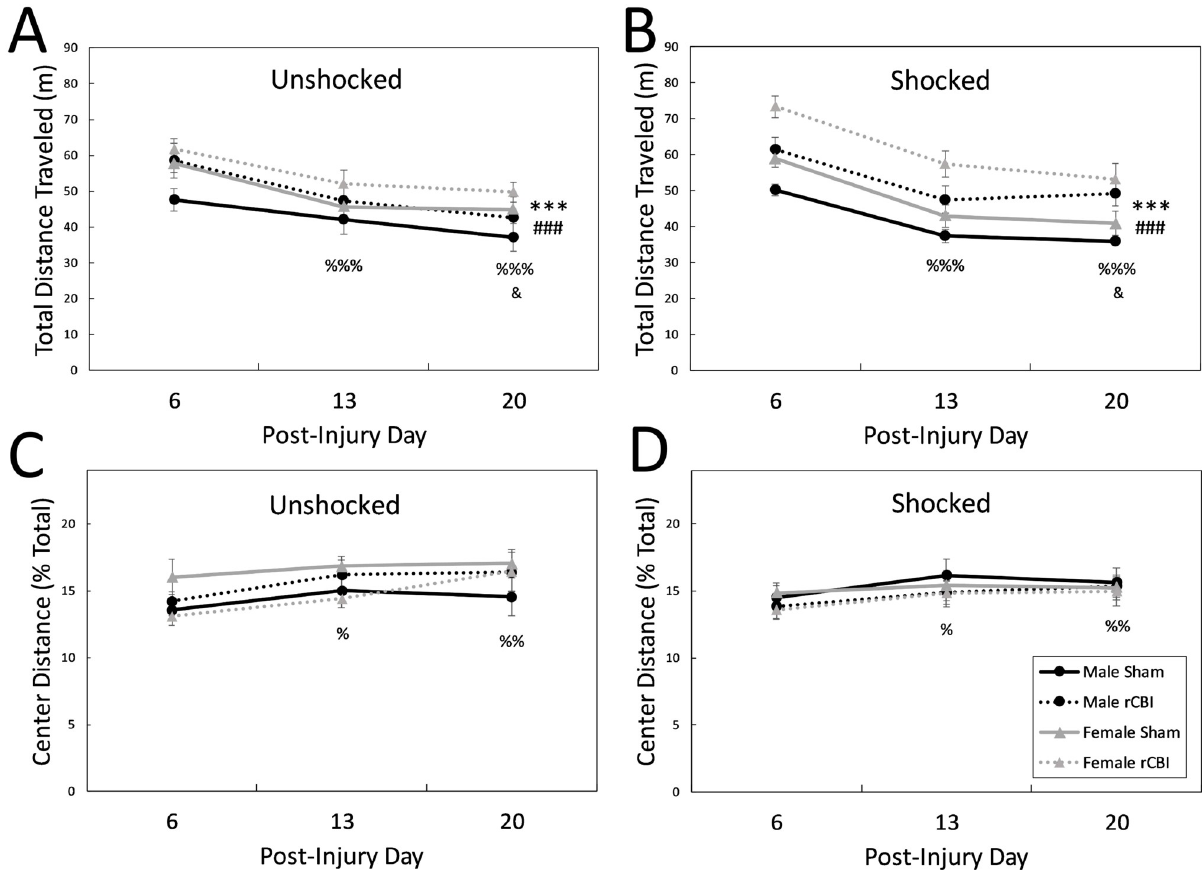
Fig 6. Total distance traveled (A & B) and activity in the center zone (C & D) in the OF arena for unshocked and shocked mice. There were main effects of injury ( ### , rCBI > Sham, p < 0.0001) and sex ( ��� , Female > Male, p < 0.0001) on the total distance traveled in the OF ( A & B ). There was also an effect of day; all mice were less active on days 13 and 20 when compared to the first exposure to the test on day 6 (%%%, Day 6 > Days 13 and 20, p < 0.0001), and there was a decrease in activity between days 13 and 20 ( & , Day 13 > Day 20, p < 0.05). The distance traveled in the center of the arena ( C & D ) was also affected by day; mice increased their exploration of the center zone on days 13 ( % , Day 13 > Day 6, p < 0.05) and 20 ( % , Day 20 > Day 6, p < 0.01) compared to day 6. There were no effects of injury, sex, or shock on center activity. OF, open field; rCBI, repetitive concussive brain